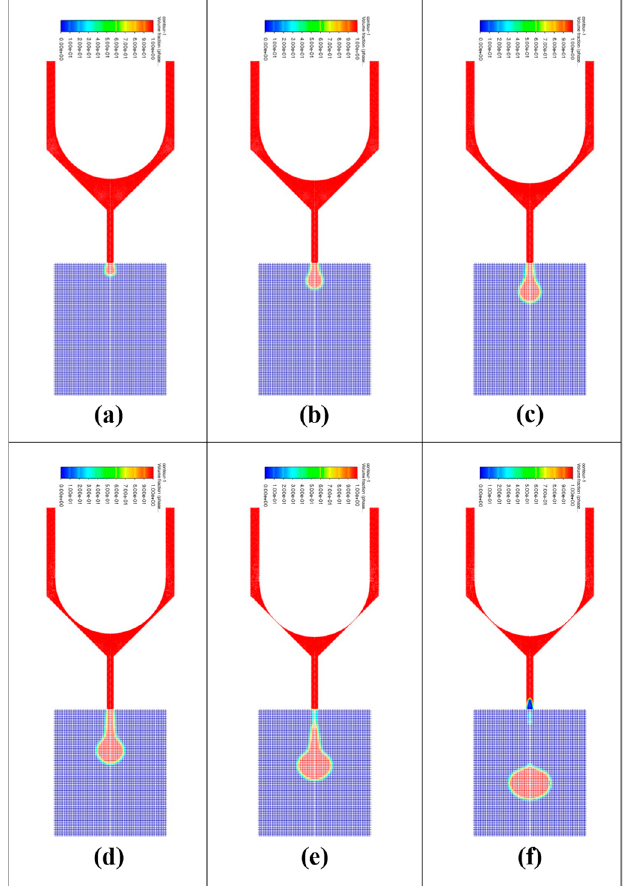
Figure 5. Results of finite element simulation of droplet diameter at different times in case 7: ( a ) time = 0.0002 s, ( b ) time = 0.0004 s, ( c ) time = 0.0006 s, ( d ) time = 0.0008 s, ( e ) time = 0.001 s, ( f ) = 0.0012 s.